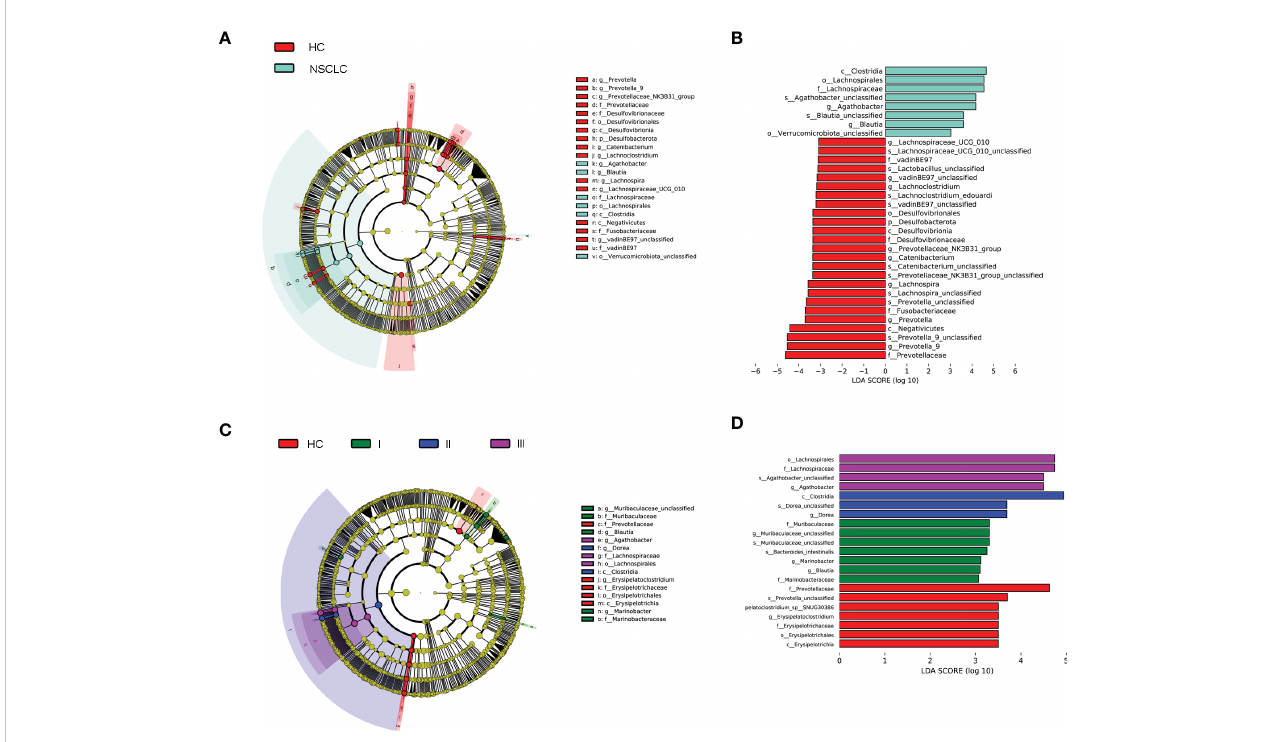
FIGURE 4 Linear discriminant analysis (LDA) combined with effect size (LEfSe). (A) Cladograms of the phylogenetic distribution of the microbiota with signi fi cant differences between early-stage NSCLC and HC analyzed by LefSe. (B) Histogram of the distribution of LDA values for LEfSe analysis of intestinal fl ora in the two groups (LAD score ≥ 3). (C) Cladograms of the phylogenetic distribution of the microbiota with signi fi cant differences across IPA grade I, grad II, grade III and HC analyzed by LefSe. (D) Histogram of the distribution of LDA values for LEfSe analysis of intestinal fl ora in four groups of samples (LAD score ≥ 3). The listed bacterial fl oras are signi fi cantly gathered for their respective groups (P<0.05, Kruskal ‐ Wallis